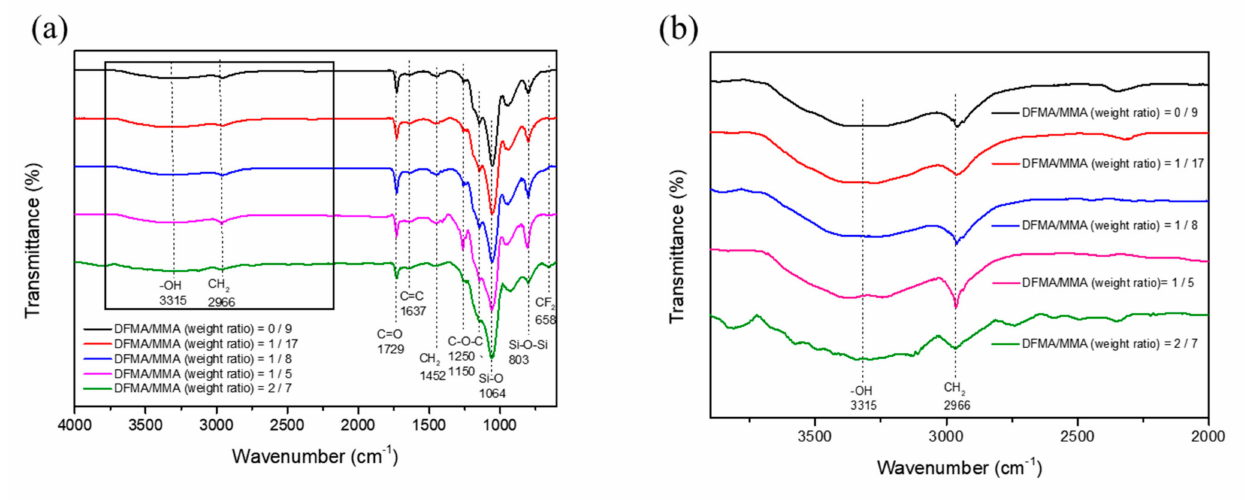
Figure 2. The Fourier transform infrared spectroscopy (FTIR) spectrum analysis of the prepared SiO 2 -polyacrylate material. ( a ) wavenumber range from 600 cm − 1 to 4000 cm − 1 and ( b ) a partial enlargement of ( a